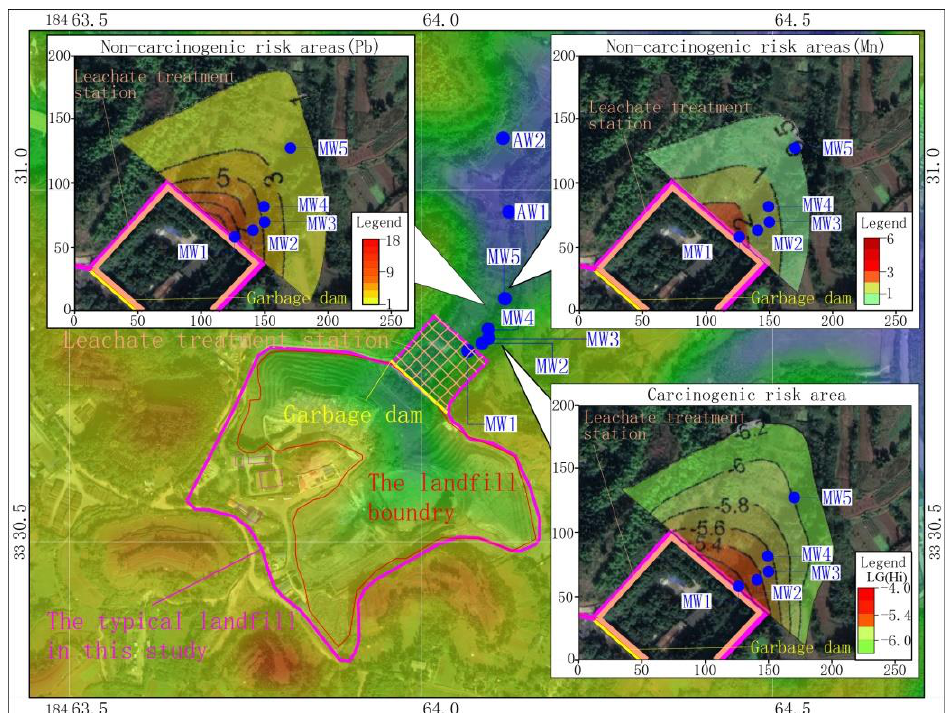
Figure 9. Spatial distribution of health risk assessment results.